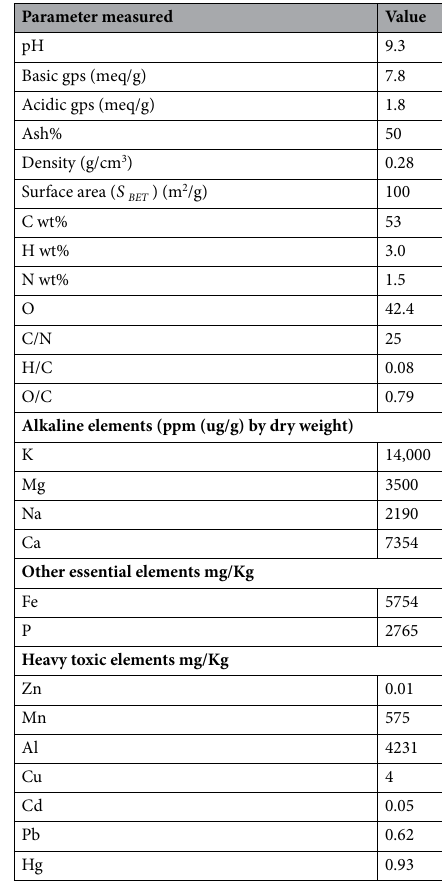
Table 1. Physico-chemical characterization of rice straw biochar.